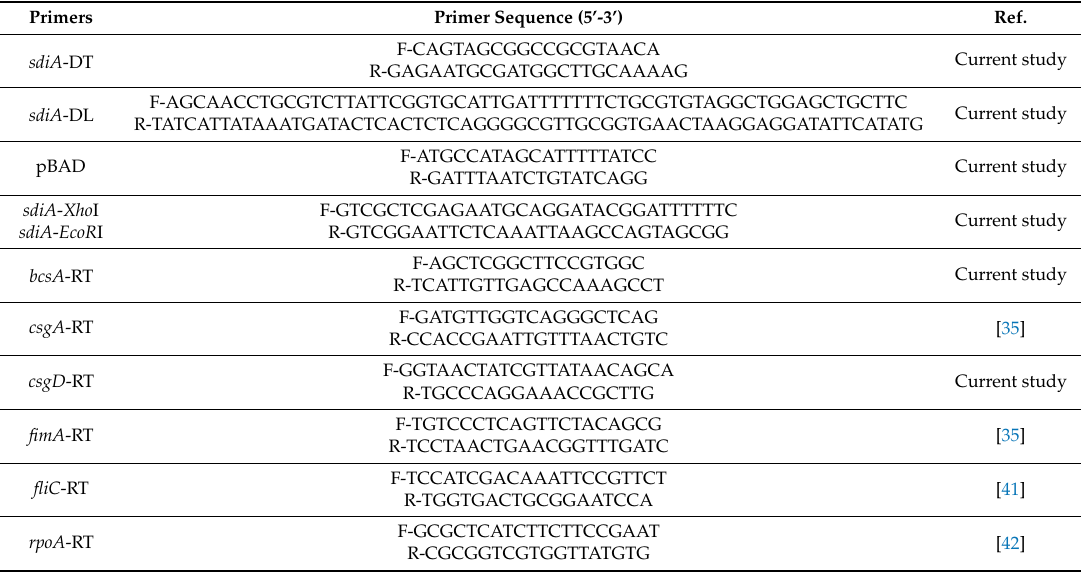
Table 2. Primers used in this